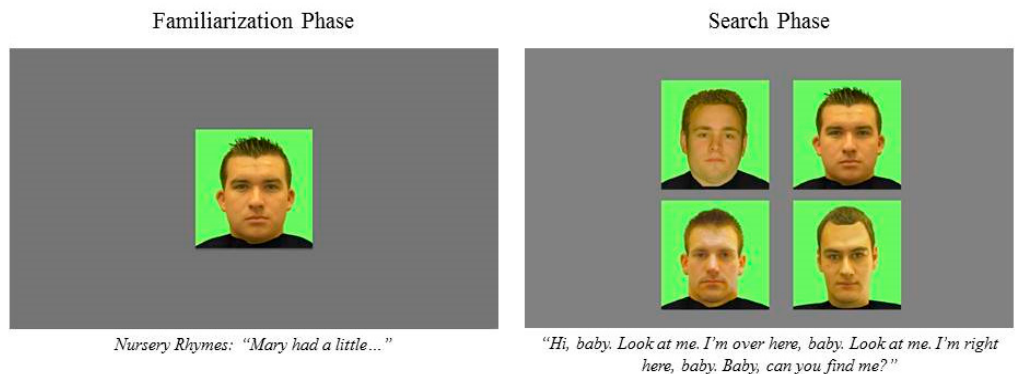
Figure 1. Sample stimuli from a neutral facial expression White male trial.